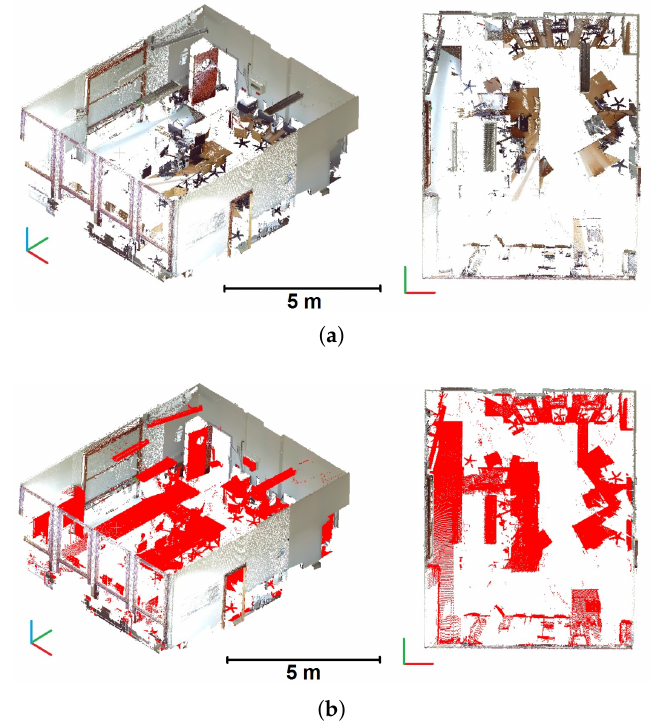
Figure 5. Point classification: ( a ) Perspective and top view of point cloud of a computer room without ceiling and floor. ( b ) Result of point